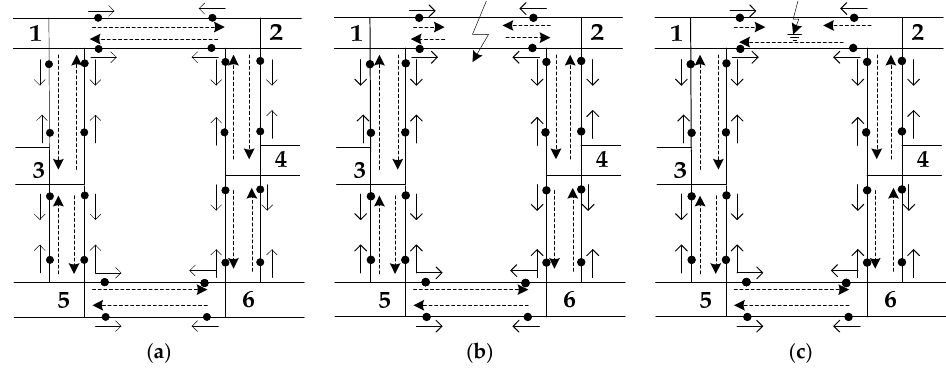
Figure 9. The current flow of the system under: ( a ) Normal operation; ( b ) Pole ‐ to ‐ pole short ‐ circuit fault; ( c ) Pole ‐ to ‐ ground short ‐ circuit fault.